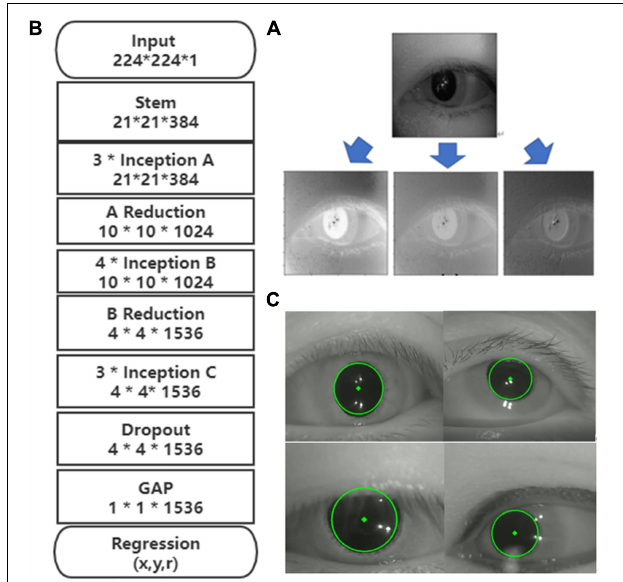
FIGURE 2 | Objection detection model for pupil location. (A) Model architecture. (B) Feature extraction with different convolution kernels. (C) Visualisation of the pupil parameters: dot – pupil centre; circle – outer radius.